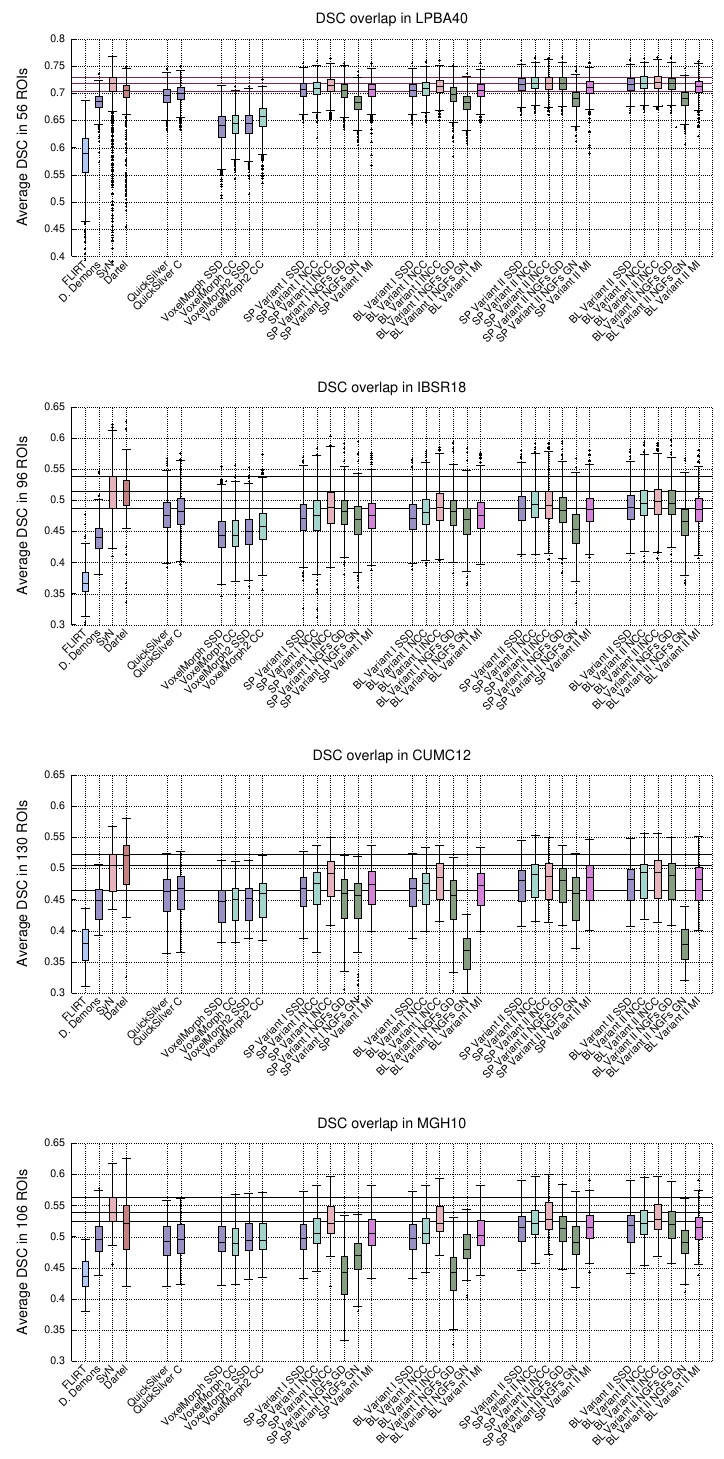
Figure 7. LPBA40, IBSR18, CUMC12, and MGH10. Distribution of the DSC values averaged over the manual segmentations in the registration experiments. The whiskers indicate the minimum and maximum of the DSC values. The horizontal lines indicate the first, second, and third quartiles of the SyN benchmark method, facilitating the comparison.